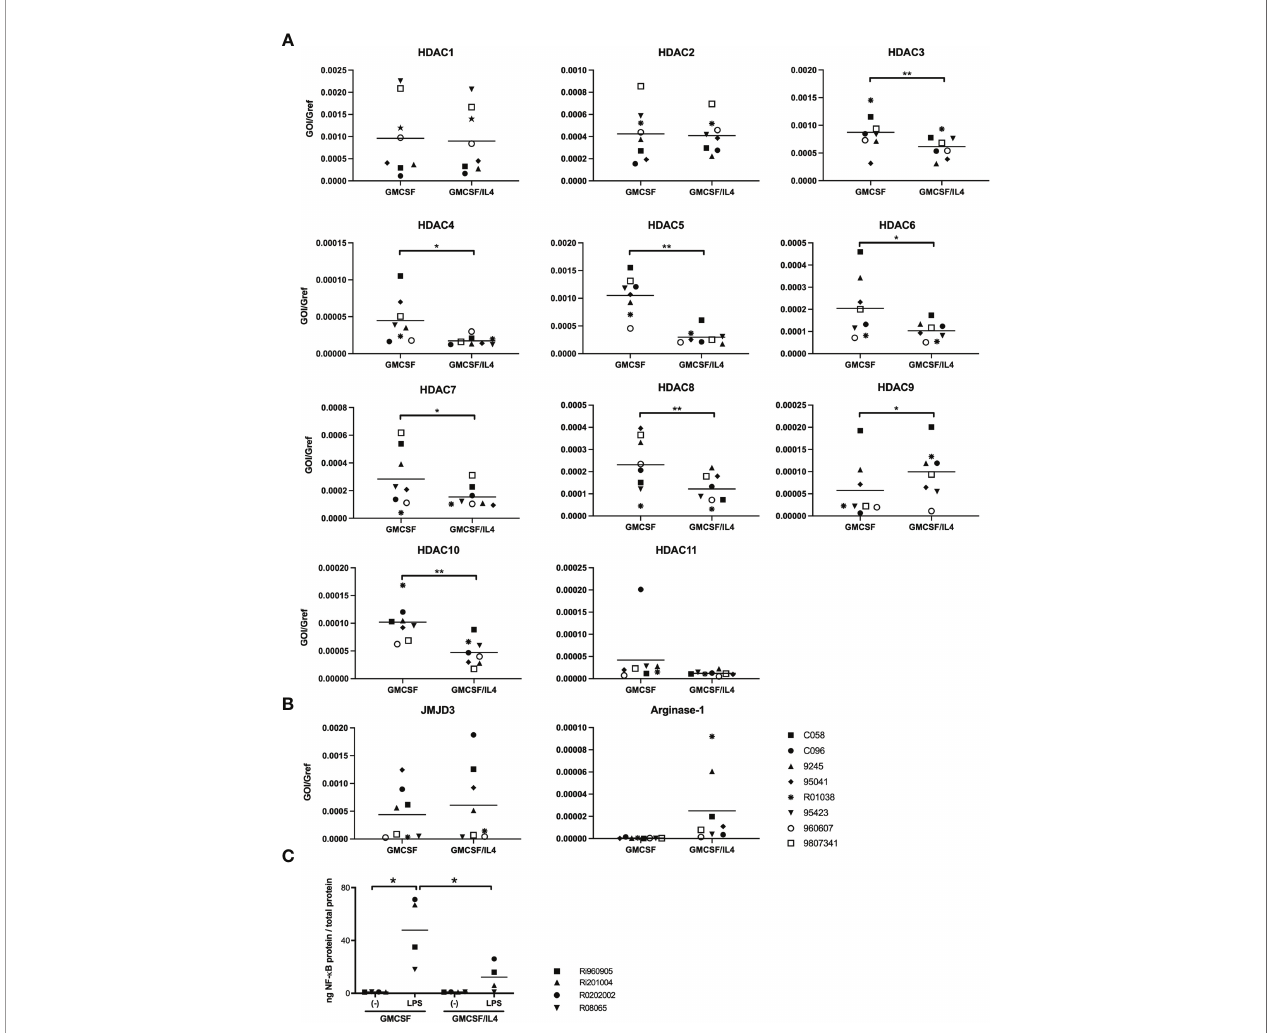
FIGURE 5 | Expression pro fi les of epigenetic modulators and analysis of LPS-induced binding of NF- k B to target DNA. (A) HDAC-encoding mRNA expression levels in GMCSF and GMCSF/IL-4-exposed microglia were quanti fi ed by real time RT-PCR. mRNA levels are expressed relative to GAPDH mRNA expression levels, *p < 0.05 **p < 0.01 paired t-test. (B) JMJD3 and arginase-1-encoding mRNA expression levels in GMCSF and GMCSF/IL-4-exposed microglia were quanti fi ed by real time RT-PCR. mRNA levels are expressed relative to GAPDH mRNA expression levels. (C) The capacity of nuclear NF- k B to bind to its DNA consensus sequence was measured in nuclear lysates of microglia exposed to GMCSF or GMCSF/IL-4 stimulated with 500 ng LPS/ml for 1h. *p < 0.05 paired t-test. Different symbols represent different donors and horizontal lines indicate